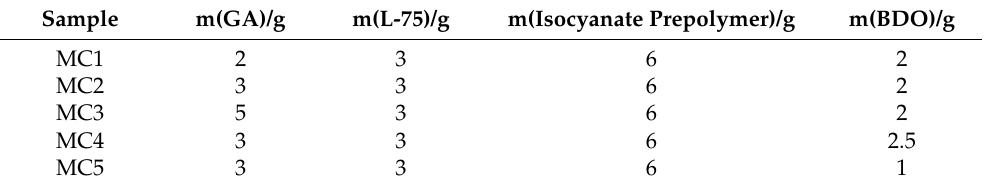
Table 1. Recipes of the microcapsule synthesis with different GA and BDO concentrations.